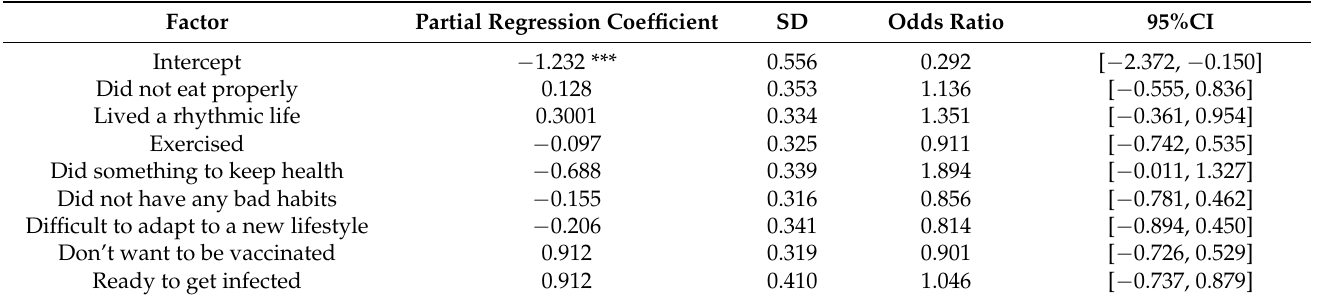
Table 9. Binormal regression of the responses to the question “Has the pandemic changed your self-assessment of health status?” (Khabarovsk